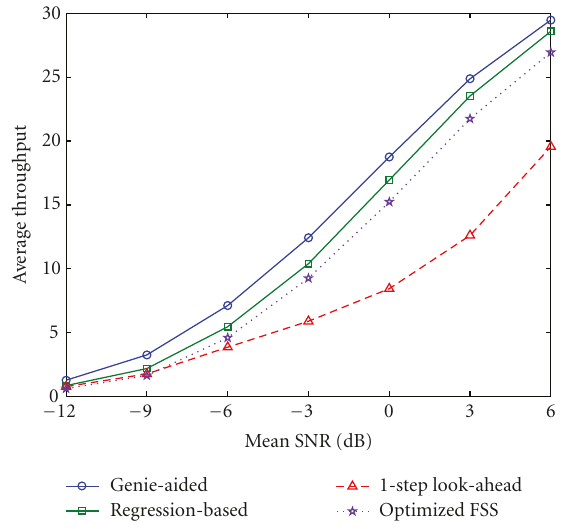
Figure 4: Average throughput versus mean SNR.